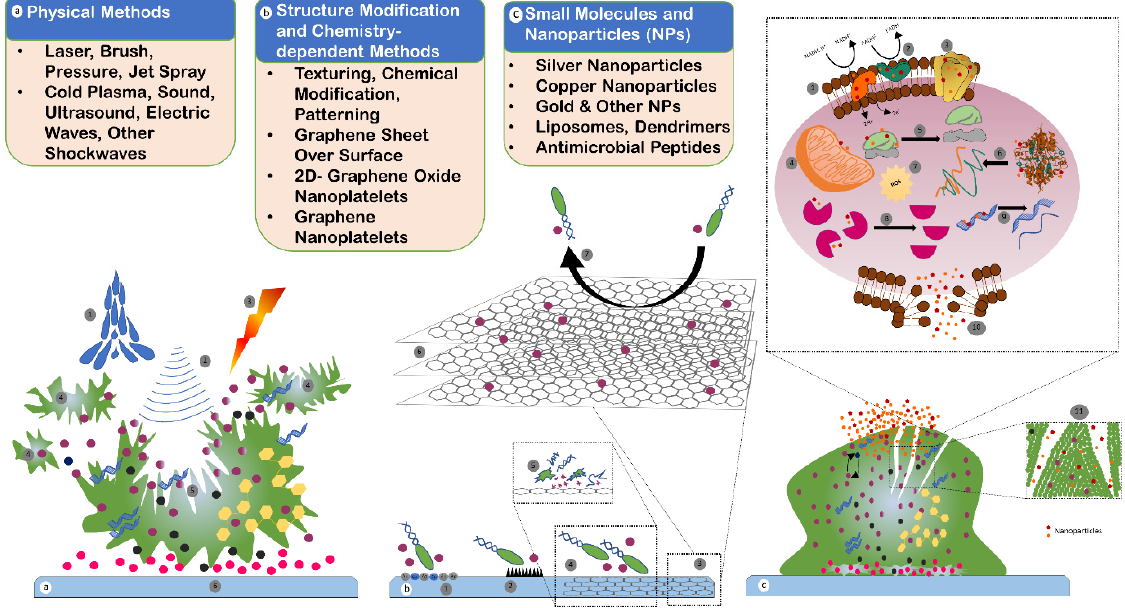
Figure 5. Strategies against biofilm: ( a ) physical methods of biofilm removal include water jet ( 1 ), sound, ultrasonic, electric and other shockwaves ( 2 ), and laser and photodynamic therapy ( 3 ) to dislodge and disrupt the biofilm in small parts ( 4 ) and to break the main biofilm region ( 5 ). The host surface or substrate ( 6 ) is not usually disturbed or modified in this method. ( b ) Structural modification and chemistry-dependent methods include techniques to change the texture, pattern, surface and material properties, surface charge, and chemical coating to repel or avoid bacterial cells attaching to the surface ( 1 , 2 ). Additionally, graphene sheets on substrate ( 3 ), graphene nanoplatelets (GNP) ( 6 ), and chemistry-dependent polyamine-functionalized quantum dots (QDs) are some advanced methods that can be used to inhibit the cell adhesion to substrate ( 7 ), and to damage the bacterial cells ( 4 , 5 ) that would provide antimicrobial properties. ( c ) Small molecules and nanoparticles developed and used for biocompatibility and antimicrobial properties include organic nanoparticles (liposomes and polymers), inorganic nanoparticles (silver, copper, gold, and iron oxide nanoparticles), and specifically designed antimicrobial peptides (AMPs) of 5 to 90 amino acids and with a molecular mass of 1 to 5 kDa. AMPs are capable of disrupting bacterial cell membranes, in addition to having enzymatic and protein activities. Nanoparticles can cause damage to the electron transport chain ( 1 , 2 ), inhibit membrane protein ( 3 ), dysfunction of the mitochondria ( 4 ), disassembly of ribosome ( 5 ), denaturation of proteins ( 6 ), oxidative stress by producing ROS ( 7 ), inactivation of enzymes ( 8 ), damage to DNA ( 9 ), damage to cell membrane ( 10 ), and degradation of EPS ( 11 ).